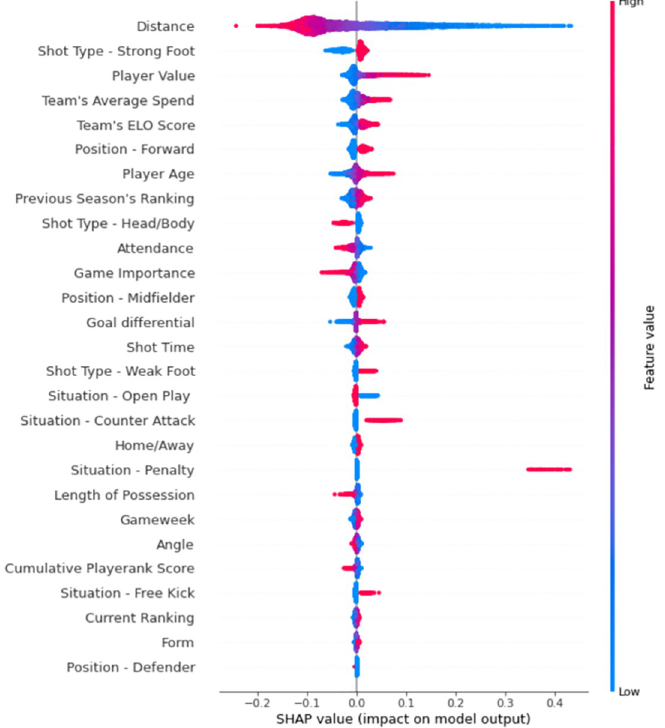
Fig 8. Important features for premier league, ordered by importance. In general, most of the models (with the exception of AdaBoost) performed relatively well on both training and test data, however, the MLP produced the best results on unseen